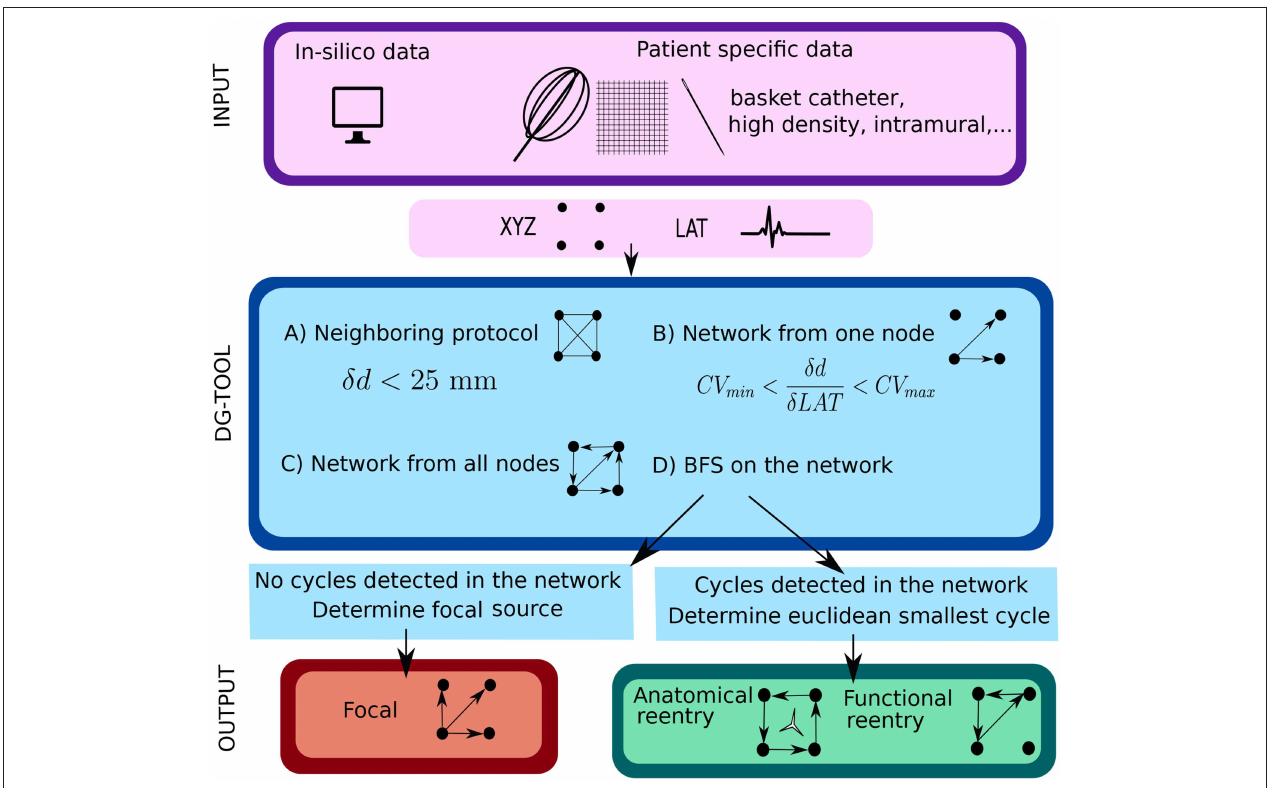
FIGURE 1 | Illustration of the work flow of the DG mapping tool. As input, the DG-tool requires for a given setup of electrodes the LAT values with the corresponding XYZ coordinates, which can be extracted from either simulation studies or a clinical setup. The input is then processed as follows in the DG-tool as presented in the flowchart. Next, we apply a loop-finding algorithm to detect cycles in the network. If cycles are not detected, we locate the source of focal activity. In case cycles were detected, the loops are merged and its center is determined. At the end, the output is visualized. In case of a focal source, arrows pointing away from a (group of) node(s) are shown, while for reentry, arrows will be plotted to visualize the reentry